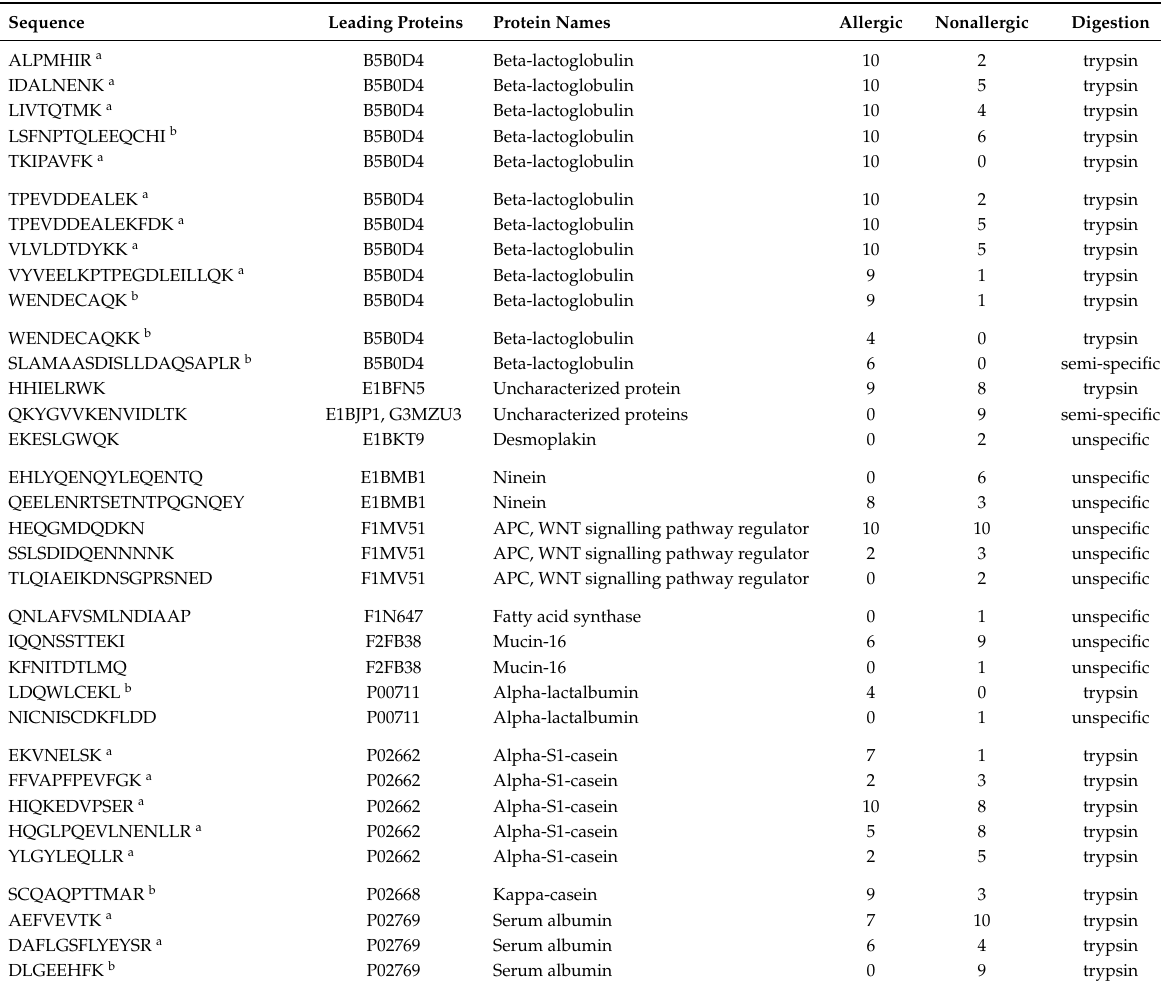
Table 2. All identified nonhuman peptide sequences that were assigned to bovine proteins, with the corresponding UniProt protein id, name of the leading protein, and in silico digestion mode. Per group of allergic and nonallergic mothers, the number of samples in which the peptide sequence was identified is